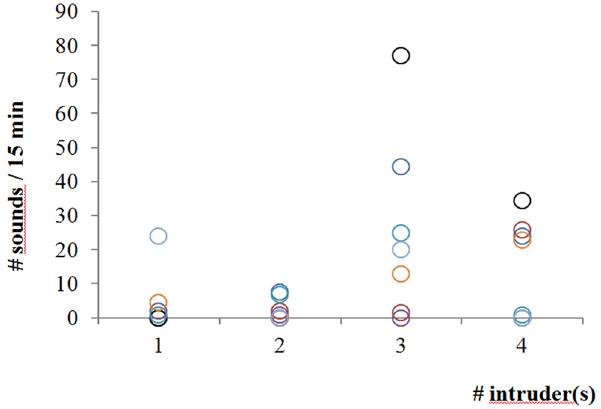
Figure 3. Oreochromisniloticus - Number of sounds produced during 28 recording sessions of 15 minutes with 1 to 4 male intruders in the tank.